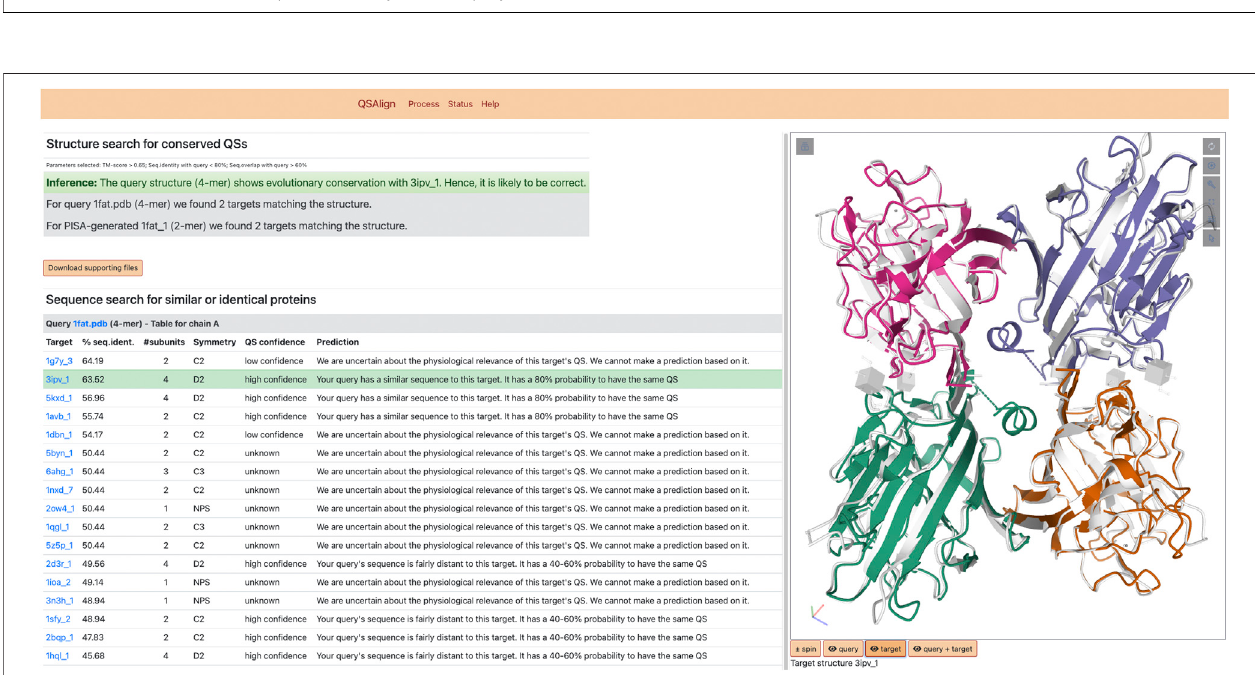
FIGURE 1 | Work fl ow of QSalignWeb. The user submits a query structure. Additional assemblies are identi fi ed using PISA. The resulting assemblies are each superposed with candidate QSs. Because structure superposition is computationally expensive, we only superpose QSs that exhibit the same number of subunits and show sequence homology. Homologs are identi fi ed based on two searches: A sequence similarity search with FASTA yields list L1, and a PFAM domain architecture similarity search yields list L0. We take the union ofthese twolists, and discard very close homologs (list L2, sequence identity > 80%). The structure superposition and inference of physiological relevance is carried out as described previously (Dey et al., 2018). On top of the results of the QS superposition, we also display a table of non-redundant QSs that share sequence similarity with the query.